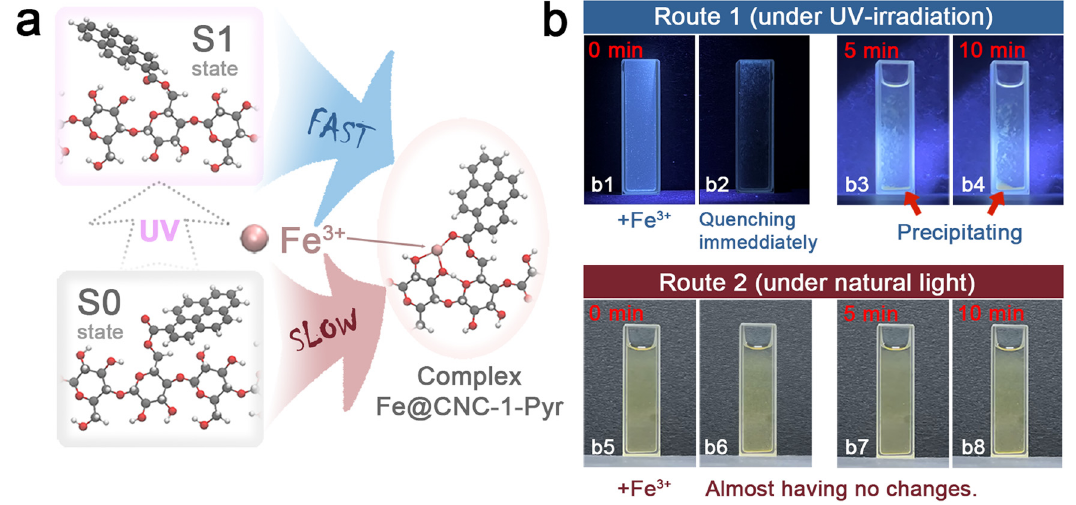
Figure 5: Excited - state geometry relaxation of CNC - 1 - Pyr for capturing and detecting Fe 3 + : ( a ) reaction path for capturing Fe 3 + and ( b ) digital photos of CNC - 1 - Pyr solution mixing with Fe 3 + solution under ( b1 – b4 ) UV light and ( b5 – b8 ) natural